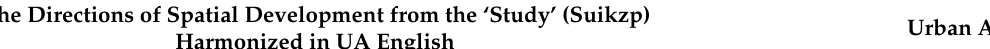
Table 1. PLU of K ˛aty Wrocławskie harmonized with UA and